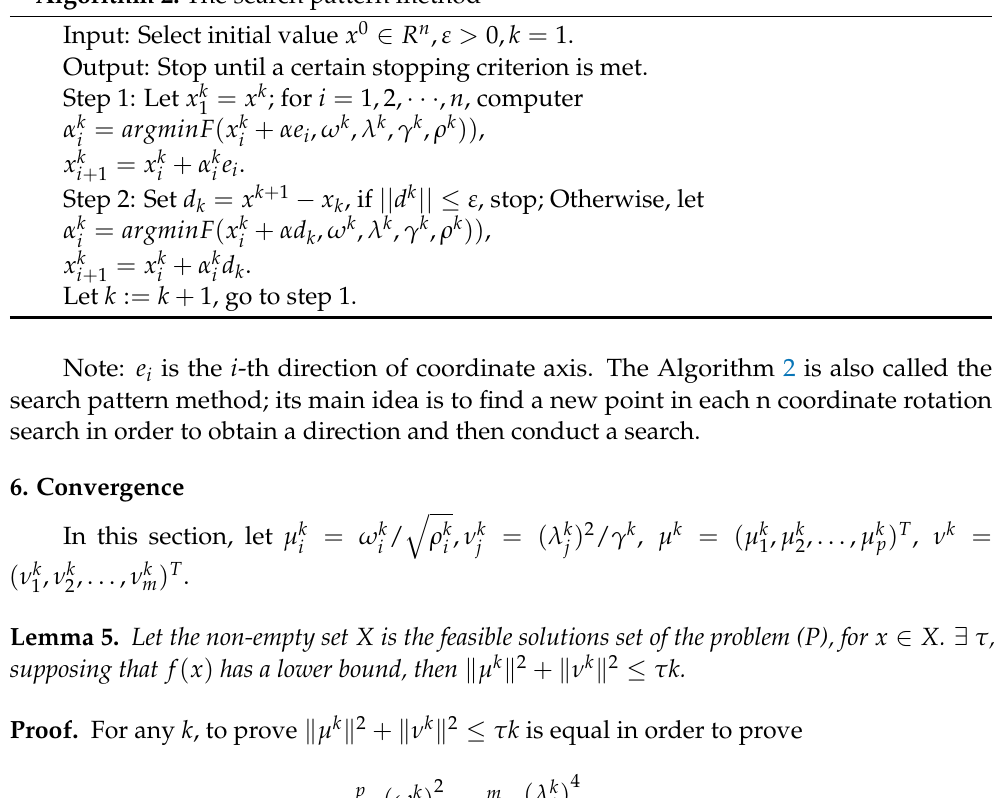
Algorithm 2 is a sub-algorithm of Algorithm 1. Algorithm 2: The search pattern